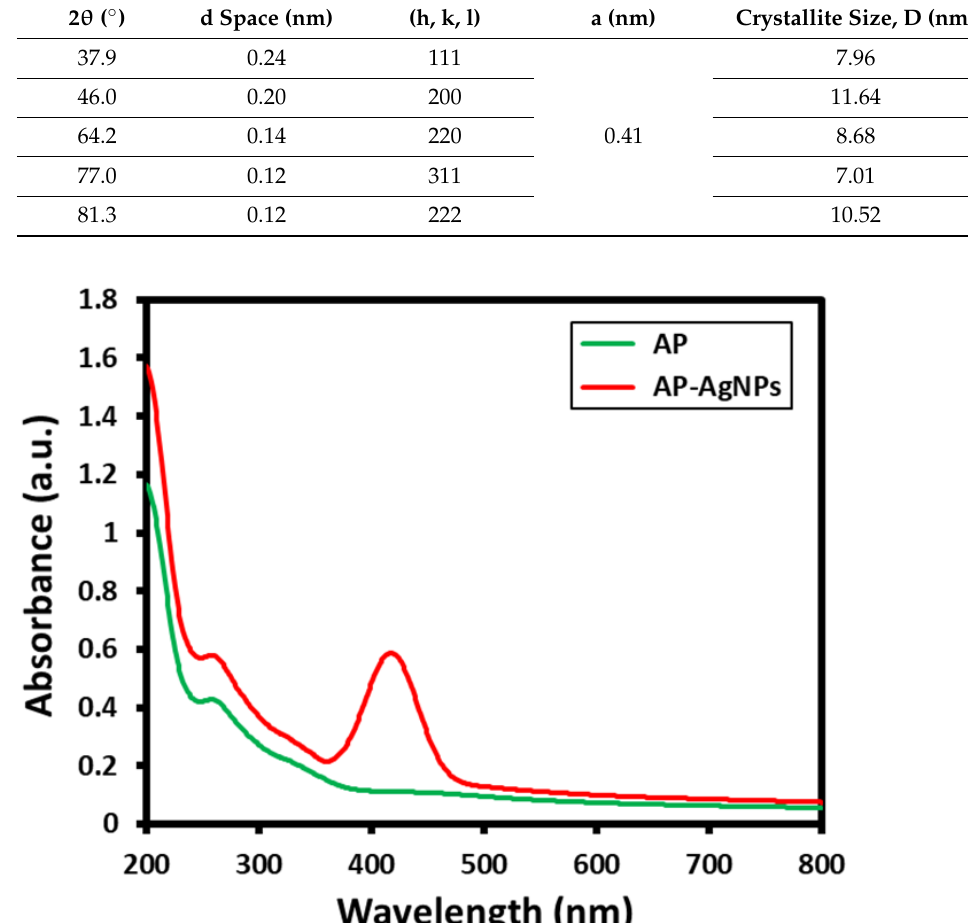
Figure 1. UV-Vis spectra of aerial parts extract of A. pseudocotula Boiss. plant (AP) and silver nanoparticles using aerial parts extract of A. pseudocotula Boiss. plant (AP-AgNPs).